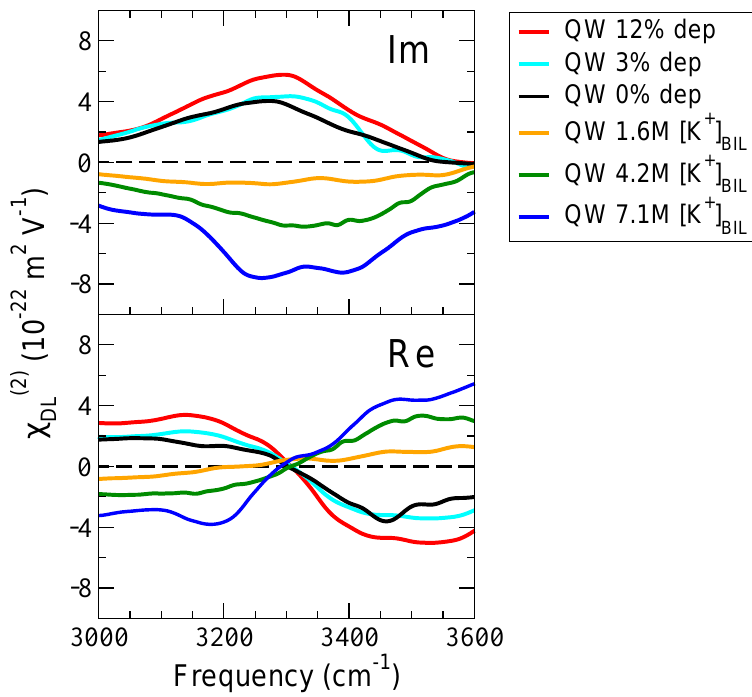
Figure 1. Calculated Im χ ( 2 ) ( ω ) and Re χ ( 2 ) ( ω ) of the DL (Diffuse Layer) of the (0001) α -quartz–liquid water interface (QW) under various chemical conditions: QW is the fully hydroxylated aqueous surface, “QW + x % dep” are deprotonated states of the aqueous surface (hence representing varied pH conditions), and “QW x M [K + ] BIL ” are fully hydroxylated aqueous surfaces with varied excess cation concentrations located in the BIL ([K + ] BIL = 1.6 M, 4.2 M and 7.1 M), the anions of the KCl electrolyte being located in the